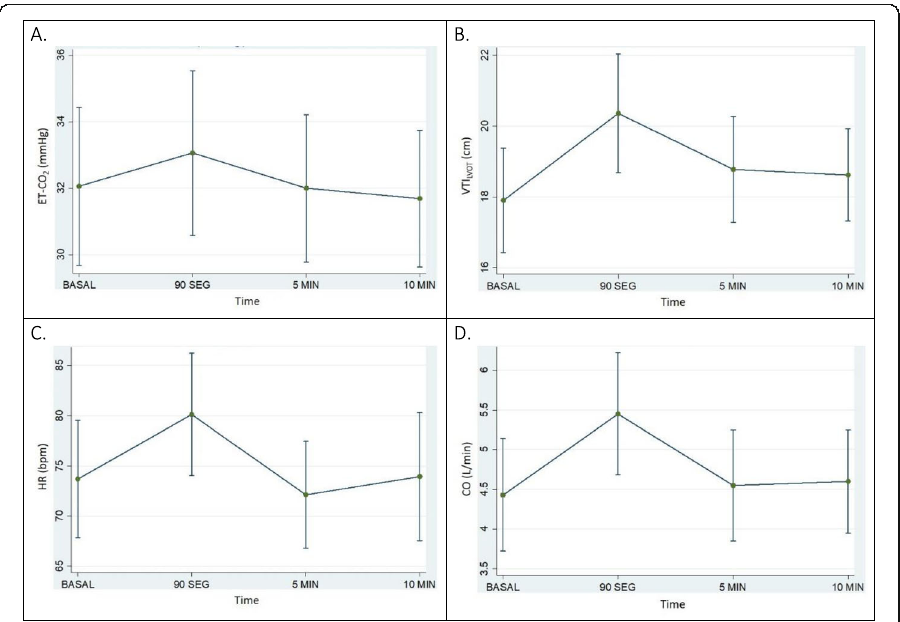
Fig. 2 Among responders, behavior during PLR maneuver of a ET-CO2, b VTI LVOT , c HR, and d CO. ET-CO2, end-tidal carbon dioxide; VTI LVOT , left ventricle outflow tract velocity time integral; HR, heat rate; CO cardiac